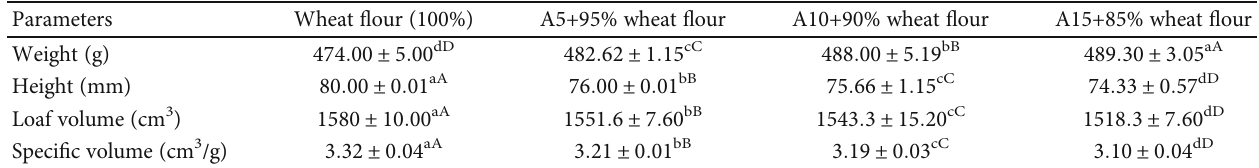
Table 7: E ff ect of substitution of amaranth fl our on physical evaluation of bread.